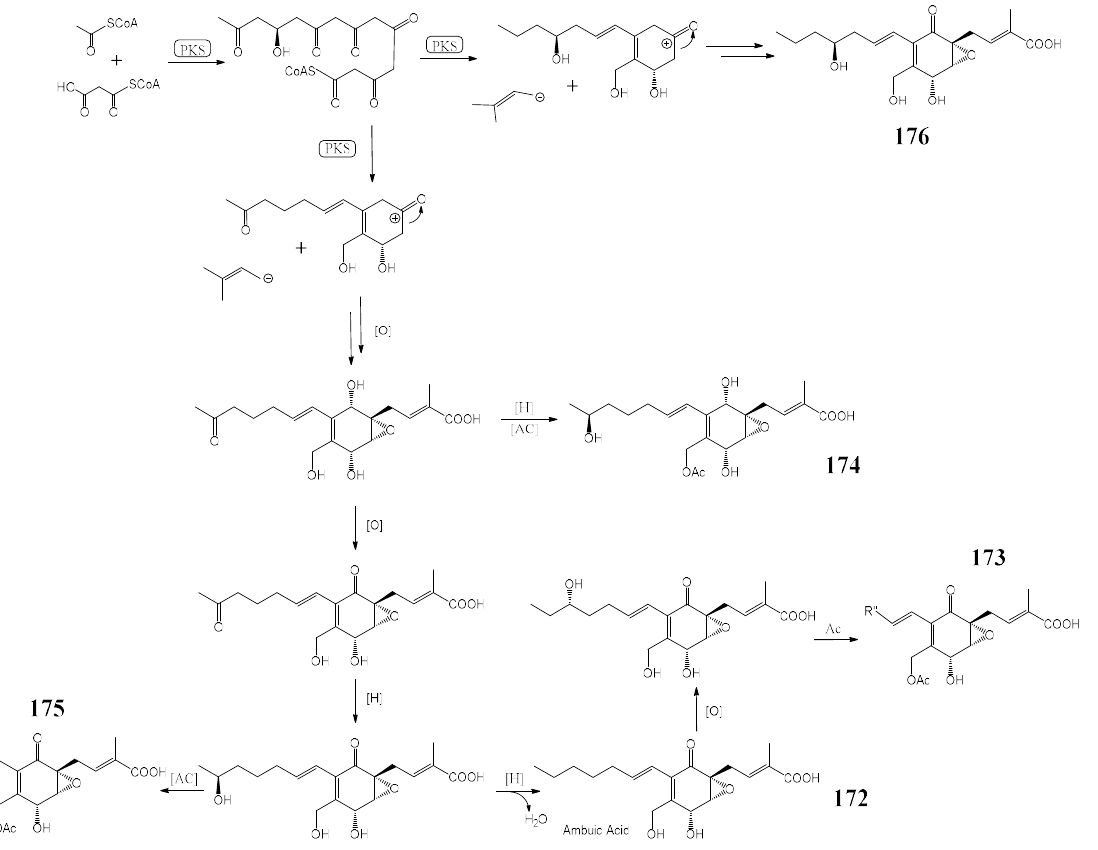
Figure 5. The suggested biosynthetic pathways of ambuic acid and its derivatives